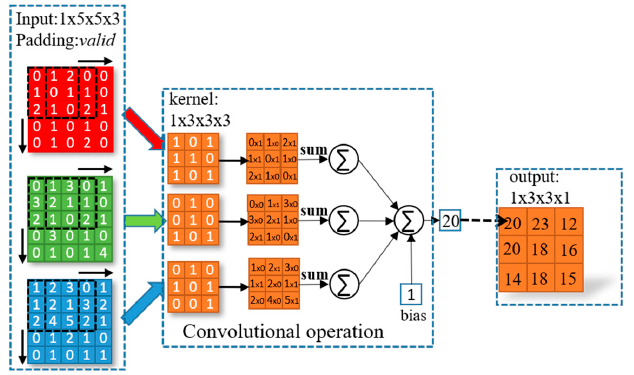
Figure 3. The principle of convolutional operation.